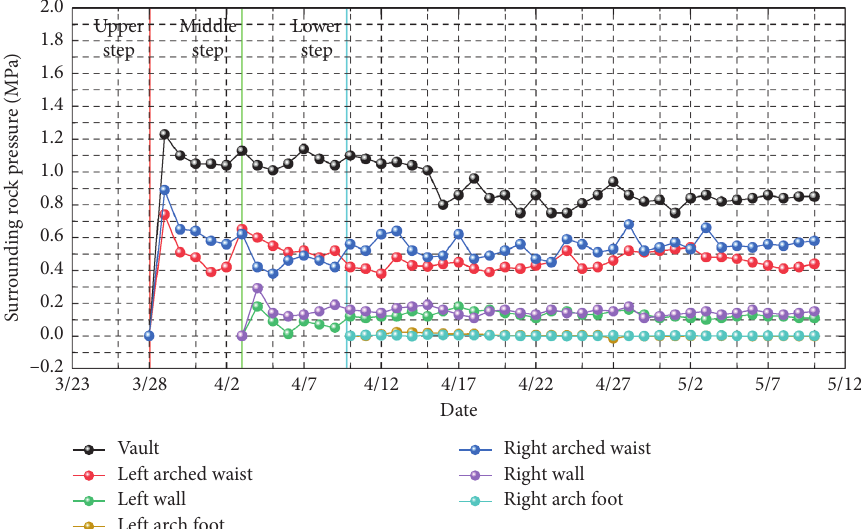
Figure 7: Pressure of the surrounding rock in section